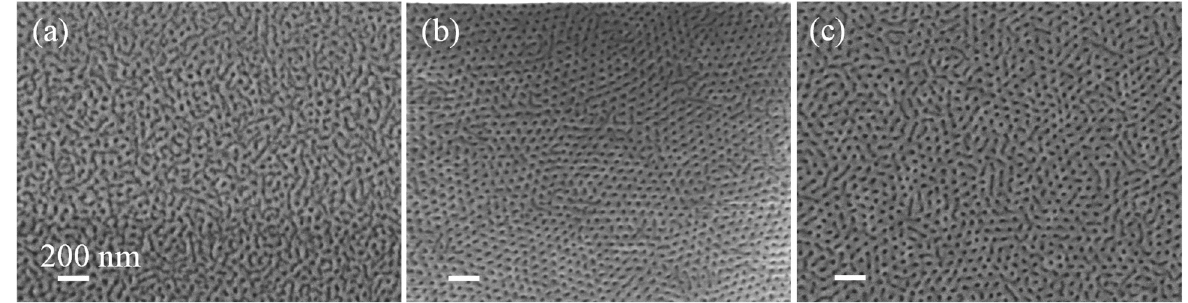
Figure 2. Random copolymer mat crosslinking on SiO 2 /MR-8 polymer substrates. SEM images of PS-b-PMMA self- assembled film (15 min THF SVA) on a PG-4 76% mat layer: ( a ) without UV treatment, ( b ) with 20 sec of UV exposure of a 120 mJ/Cm 2 dose, and ( c ) with 1 h of UV exposure of a 27,108 mJ/Cm 2 dose.